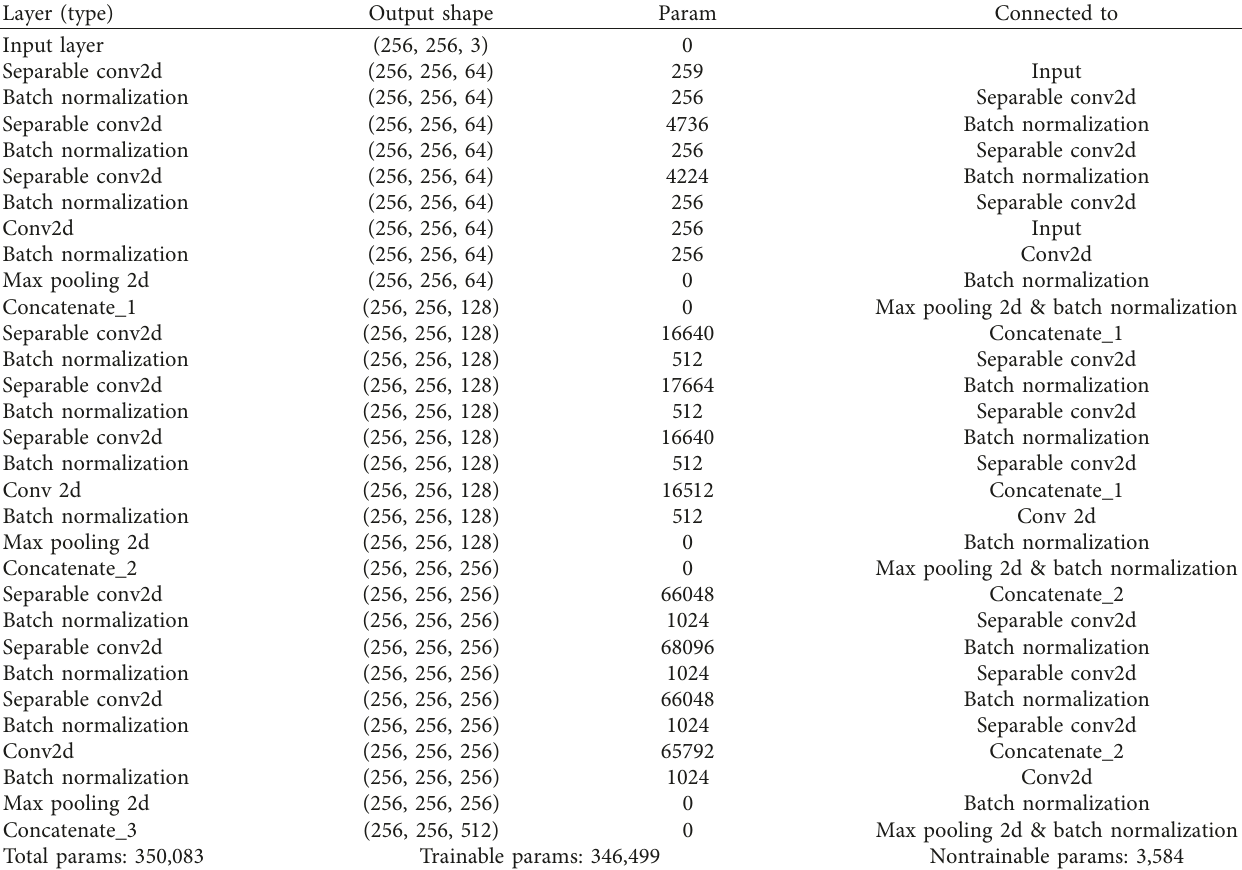
Table 1: Architecture of the DSRCN.